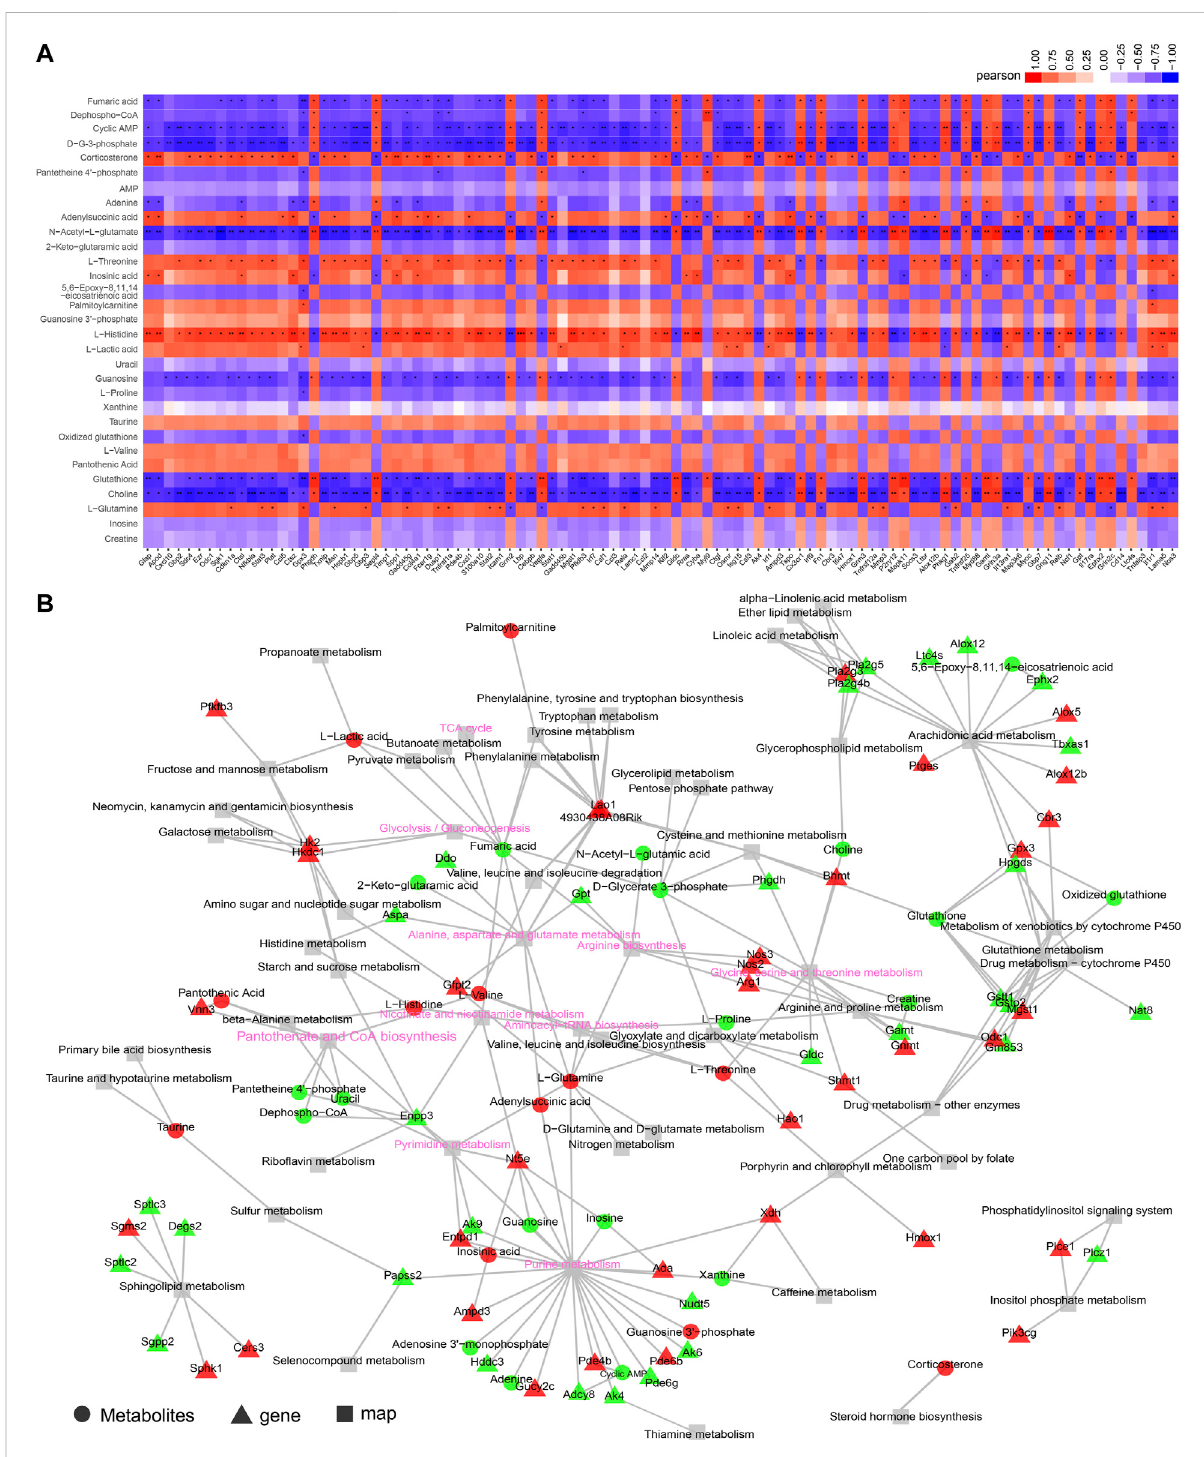
FIGURE 6 Integrative analysis of transcriptome and metabolome. (A) Correlation heatmap of links between top 100 expressed genes and metabolites basedonthePearsoncorrelationalgorithm.Thecolorbardenotesthevalueofcorrelationcoef fi ciency,*p < 0.05,**p < 0.01,***p < 0.001. (B) KGML networkbuildingbasedontheDEGsandDEMstoobtainthecriticalnodesandmetabolismpathways.Thetrianglewithredorgreendenotestheup- or downregulated DEGs, respectively. The circle with red or green denotes the up- or downregulated DEMs, respectively, and the square denotes the pathway. The key metabolic or signaling pathways were shown with pink